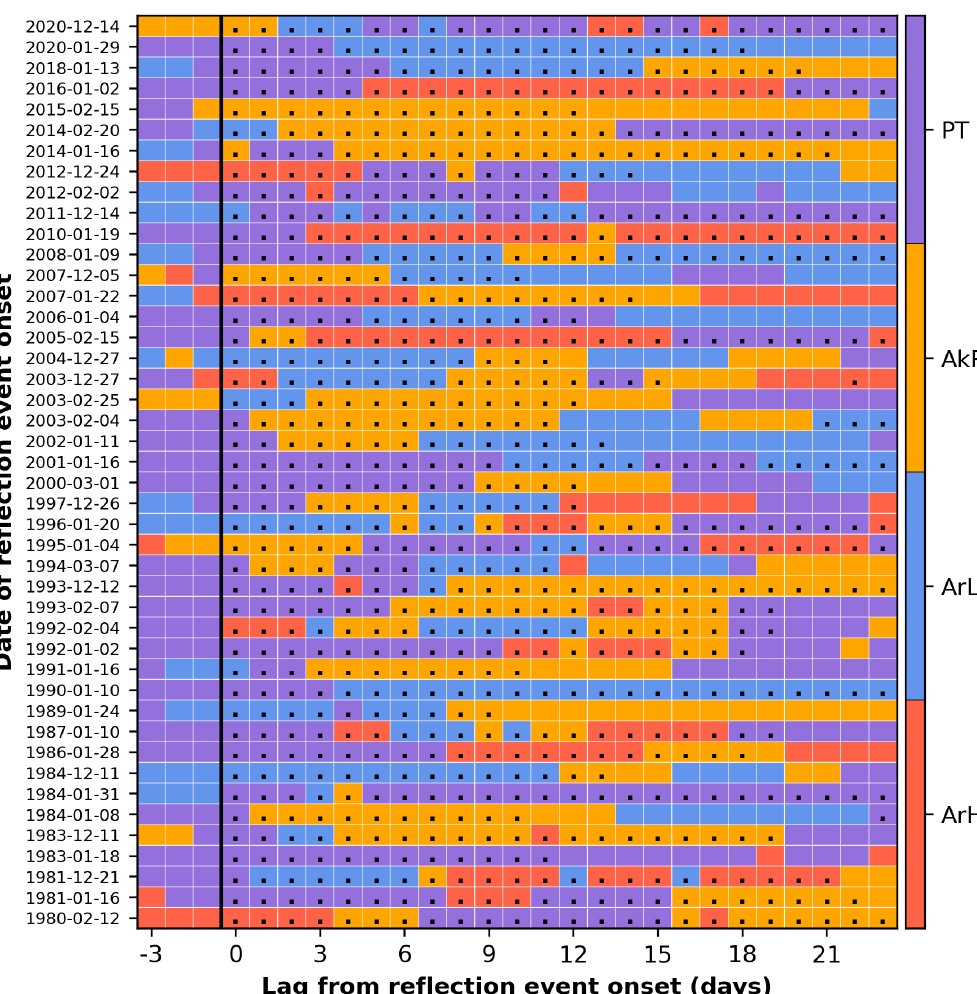
Figure 11. Evolution of the daily regime assignment during the 44 reflection events. Days with RI > 1 are shown with